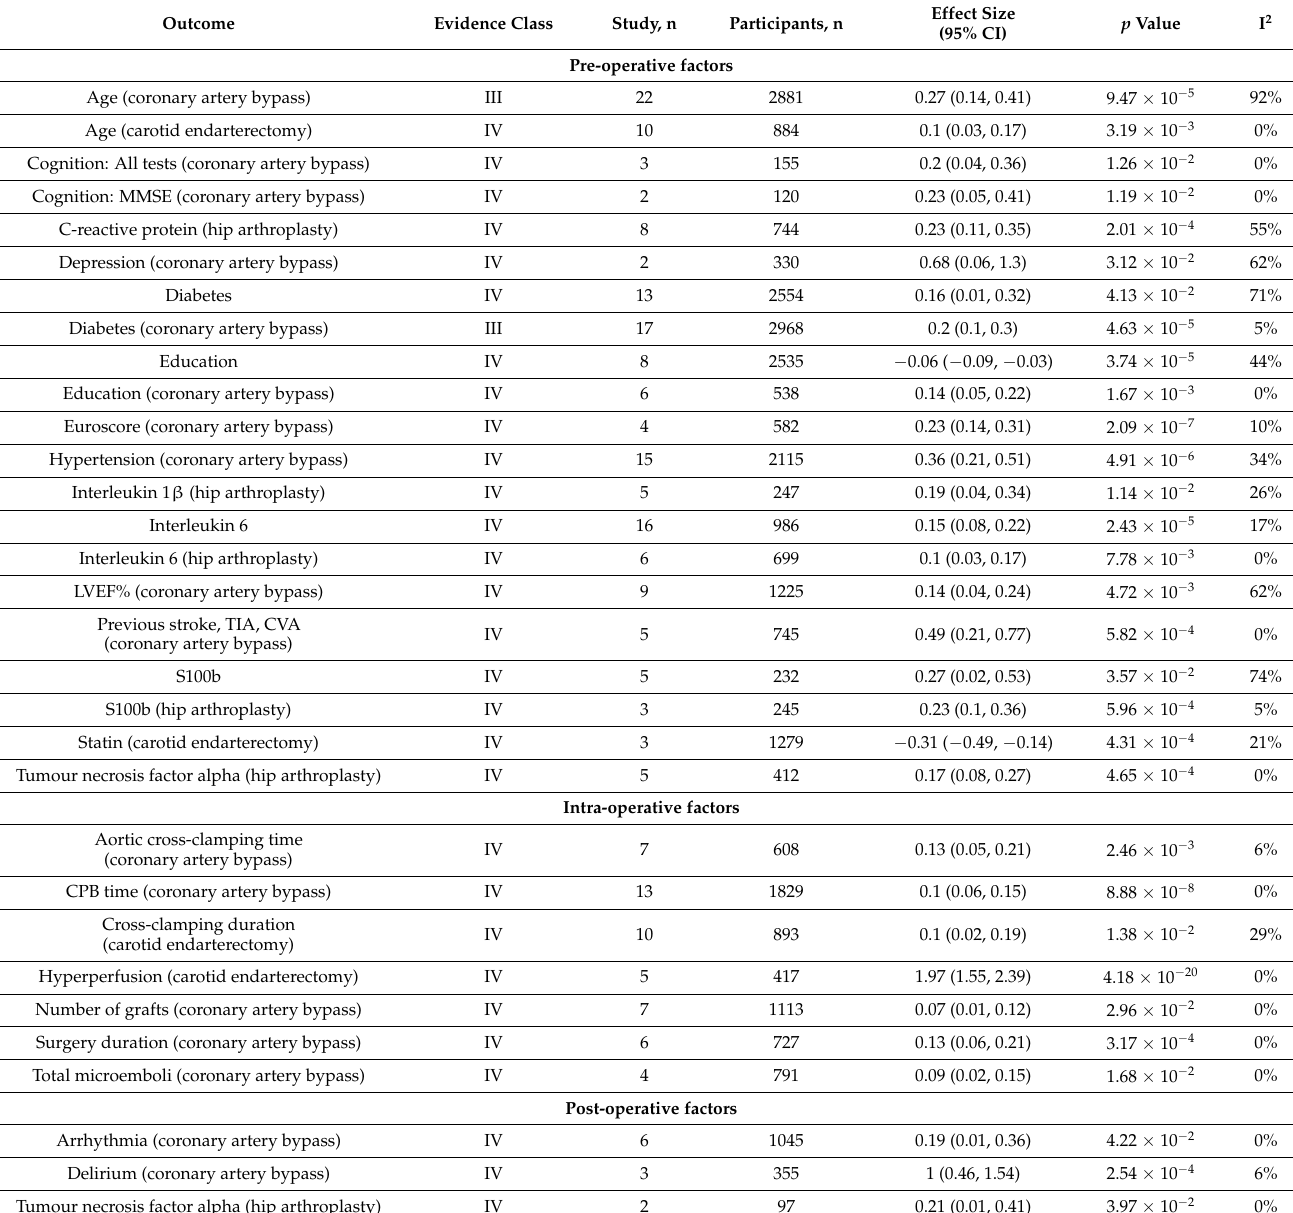
Table 2. Summary of risk factors displaying significant ( p ≤ 0.05) associations with post-operative cognitive